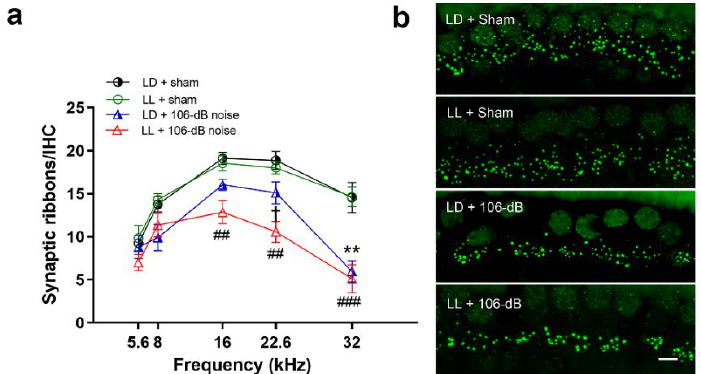
Figure 6. Synaptic ribbon counts in the LD and LL groups after 106 dB noise exposure. ( a ) The number of synaptic ribbons decreased significantly in the LD group at 32 kHz and the LL group at 16, 22.6, and 32 kHz after 106 dB noise exposure, while the significant difference between LD and LL groups was observed at 22.6 kHz. Data are mean ± SEM ( n = 5–6 for each group). ** p < 0.01 for LD + 106 dB noise vs. LD + sham, ## p < 0.01, ### p < 0.001 for LL + 106 dB noise vs. LL + sham, † p < 0.05 for LD + 106 dB noise vs. LL + 106 dB noise. ( b ) Representative images of synaptic ribbons stained by CTBP2 (green dots) over the 22.6 kHz region. Scale bar = 5 µm.